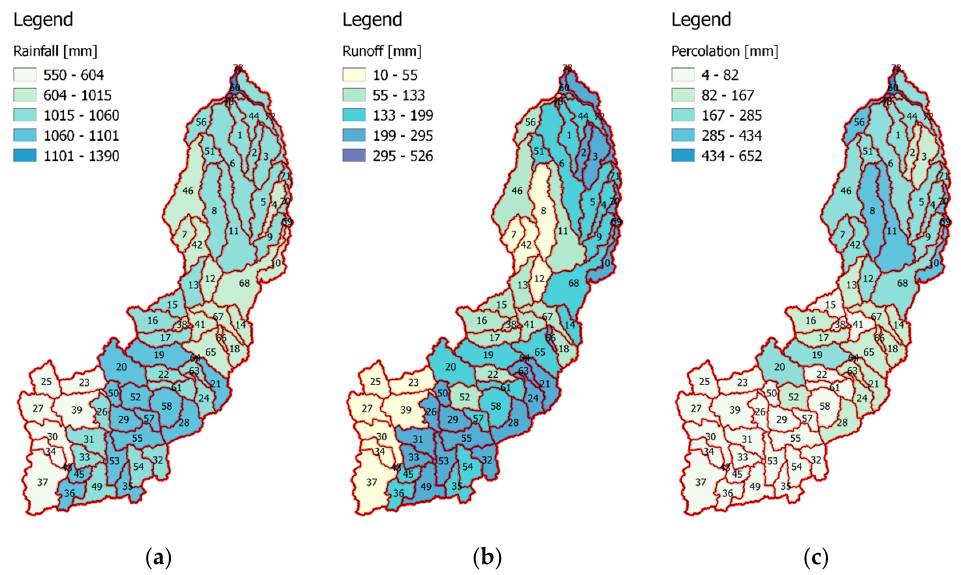
Figure 5. Results of Scenario 1 Soil and Water Assessment Tool (SWAT) model (annual means for the period 1992–2013 in mm): ( a ) Precipitation; ( b ) Surface runoff; ( c ) Percolation.